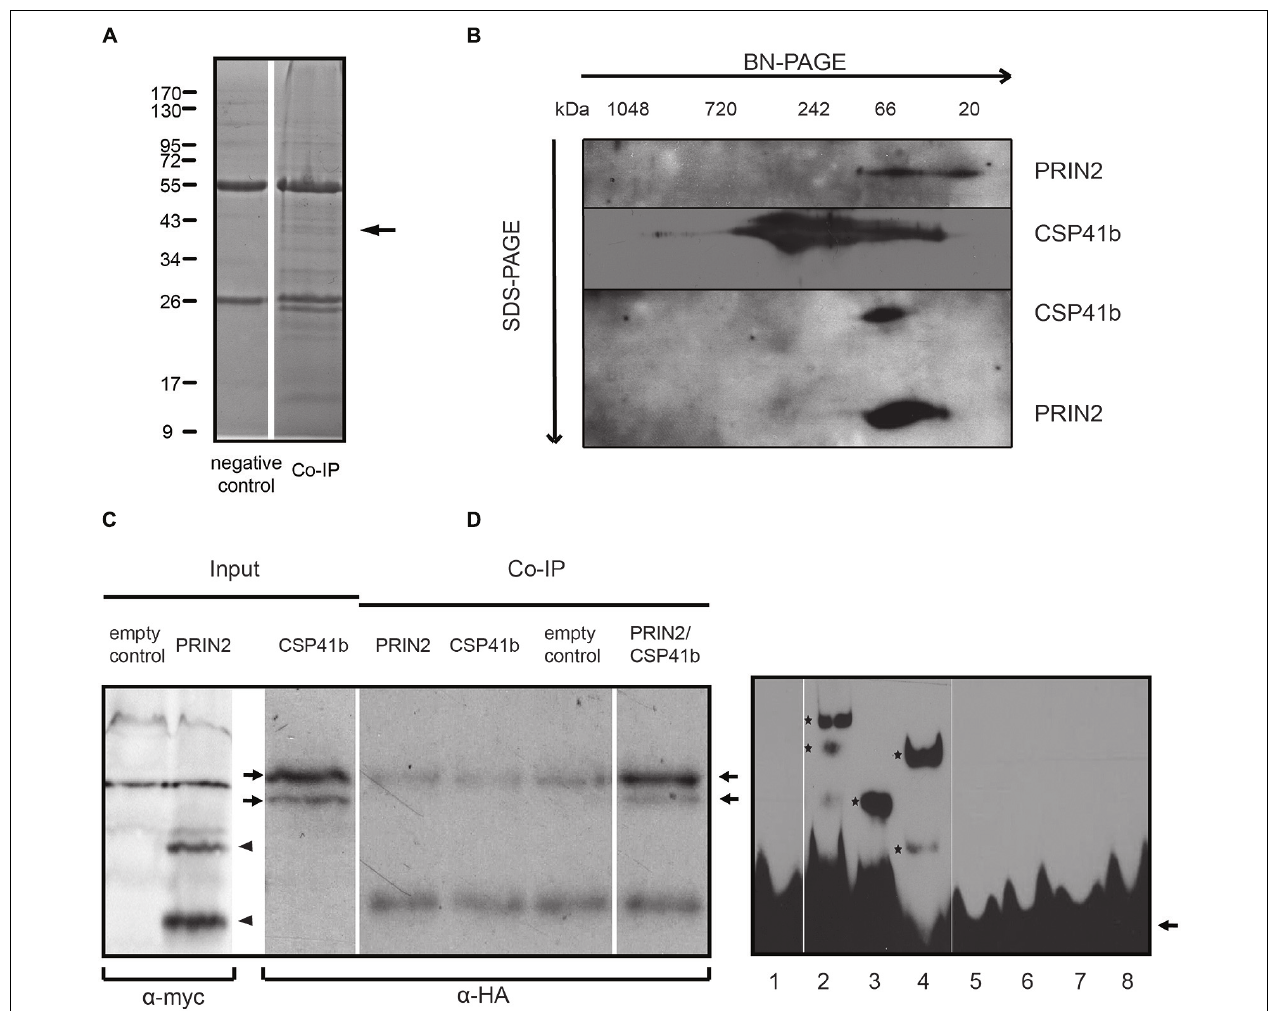
FIGURE 1 | PRIN2 interacts with CSP41b and forms a DNA-binding complex. (A) Native PRIN2-cMyc protein complex from Arabidopsis chloroplasts was immunoprecipitated with anti-cMyc antibody and proteins were separated on the SDS-PAGE. Non-transformed Col-0 chloroplasts were used as a negative control. Protein bands were cut from the gel and analyzed by mass spectrometry. An arrow indicates the position of the band where CSP41b was identified. (B) PRIN2 interaction with CSP41b detected by 2D Native PAGE/SDS PAGE gel. Recombinant PRIN2, CSP41b and 1:1 mixture of both proteins were incubated in the binding buffer and run on the 4–12% Native Bis-Tris Gel. Individual stripes were then cut and loaded on the 12% SDS PAGE gel. Proteins were detected with anti-His peroxidase. (C) Interaction between PRIN2 and CSP41b in vivo Co-IP assay. Full length PRIN2-cMyc and CSP41b-HA fusion proteins were expressed in Arabidopsis protoplasts and Co-IP was performed using anti-cMyc antibody linked to protein G-covered magnetic